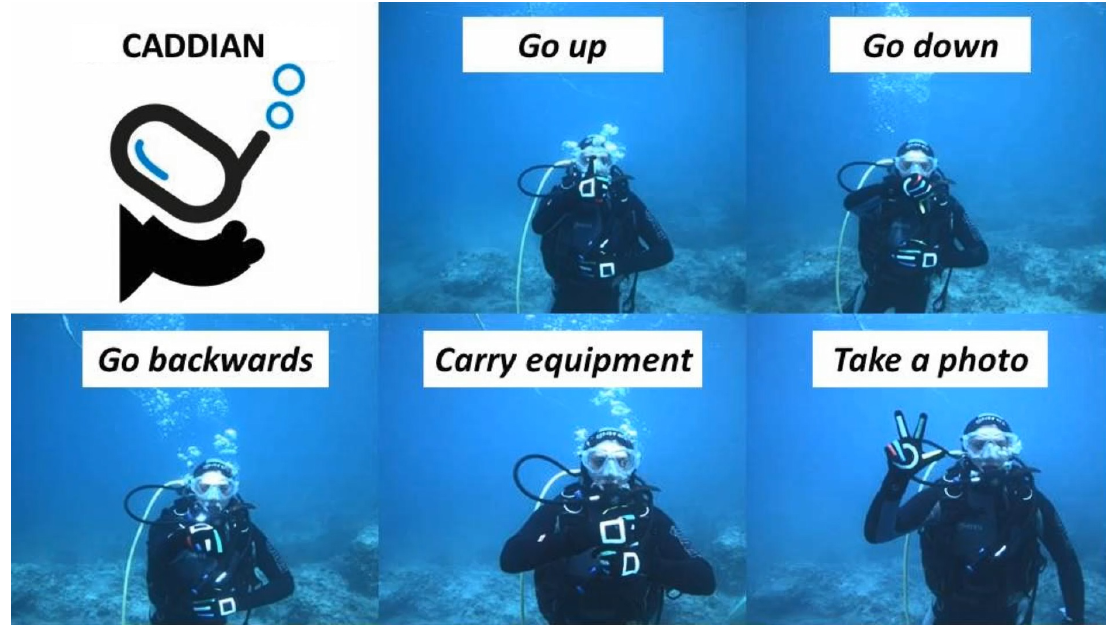
Figure 3. A subset of the Caddian gestures tested during 2015 validation trials.